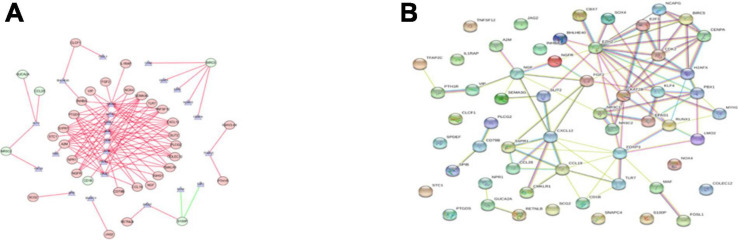
The main regulatory network constructed based on prognosis-related IRGs and CRTFs. (A) The main regulatory network was constructed using Cytoscape for visualization. The circulars represent differentially expressed prognostic immune-related genes, and the purple triangles represent prognosis-related cancer-related transcription factors, respectively. The red circulars represent high-risk genes, and the green circulars represent low-risk genes. Red lines represent positive correlations and green lines represent negative correlations. (B) The PPI network was predicted using the Search Tool for the Retrieval of Interacting Genes online database. Analyzing the functional interactions between proteins may provide insights into the mechanisms of generation or development of CRC.